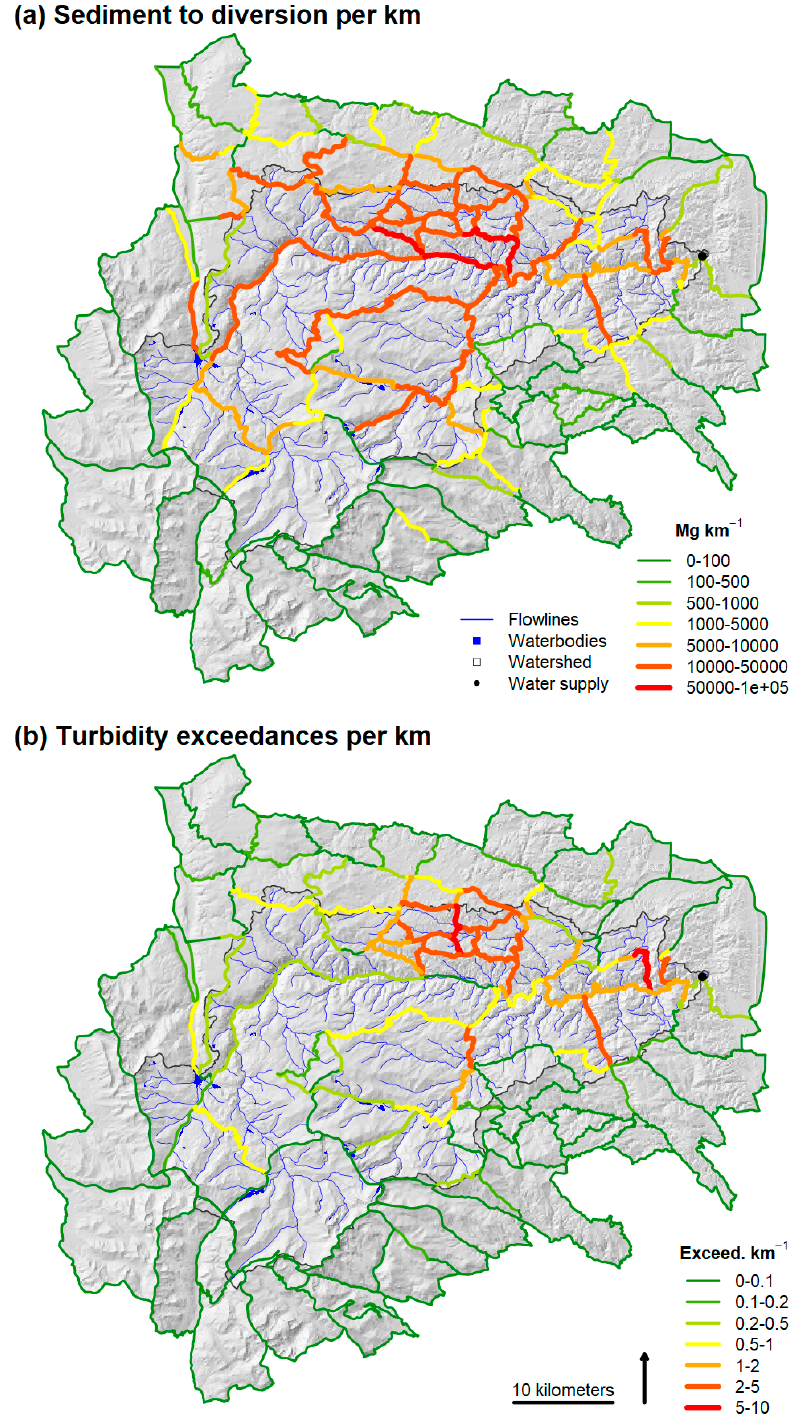
Figure 7. Total transmitted risk for all fires from ( a ) sediment to diversion and ( b ) turbidity exceedances normalized to edge length in kilometers for 2-year rainfall erosivity.